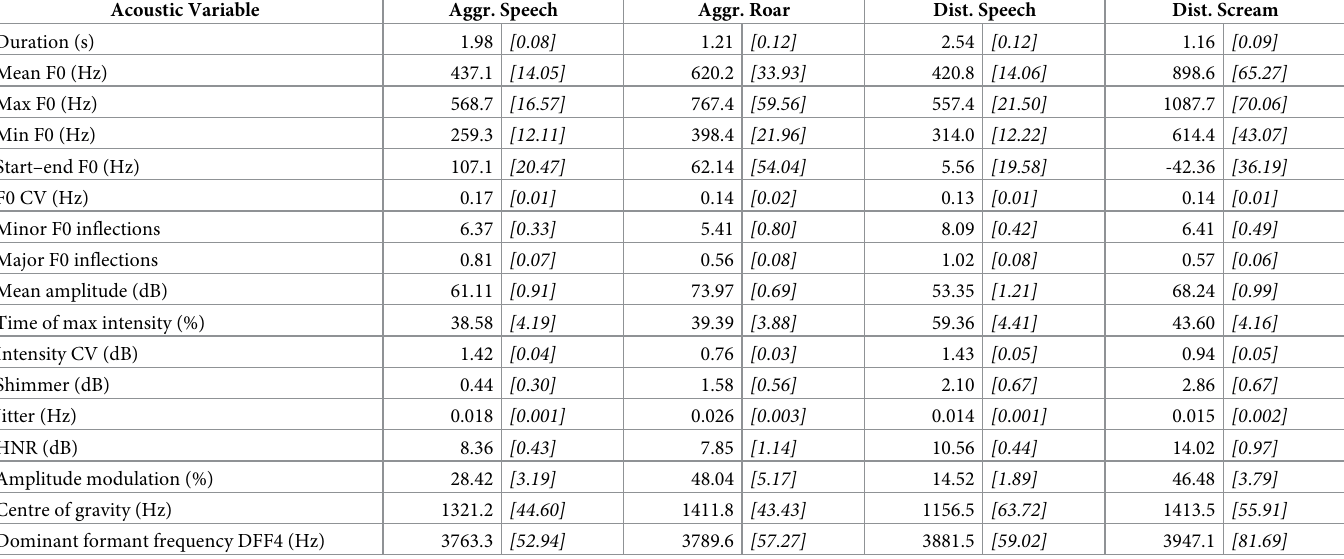
Table 2. Mean acoustic characteristics of female vocal stimuli. Figures in square brackets represent standard errors. Acoustic